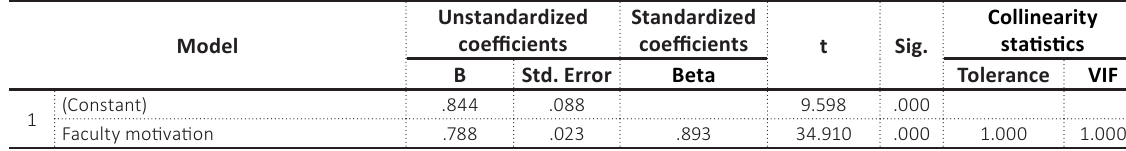
Table 8. Impact of faculty motivation on faculty performance: Indirect